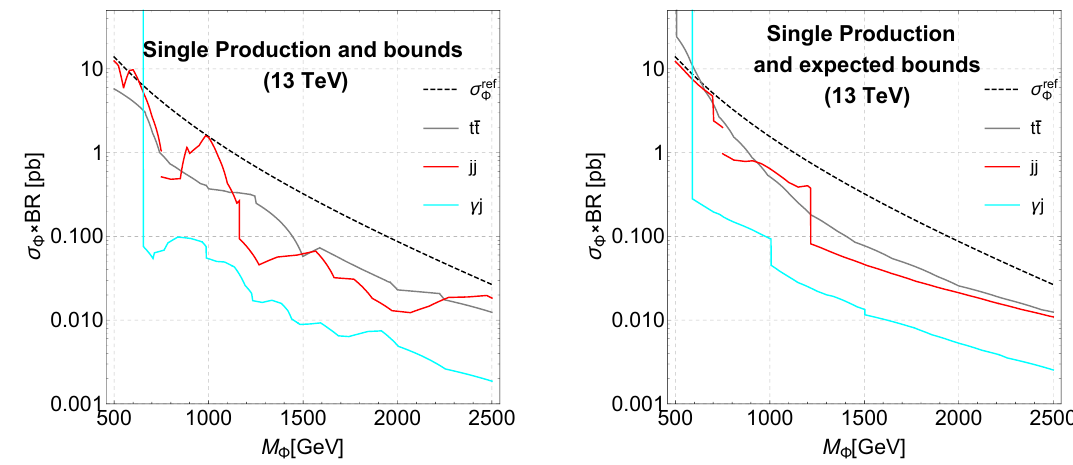
Figure 3 . Current observed (left) and expected (right) experimental bounds on the production cross section of t (cid:22) t , jj , and j(cid:13) resonances as a function of the resonance mass. As a reference, we give the single production cross section of (cid:8) for (cid:20) g =f (cid:8) = 10 TeV (cid:0) 1 as a function of M (cid:8) . The production cross section scales with ( (cid:20) g =f (cid:8) ) 2